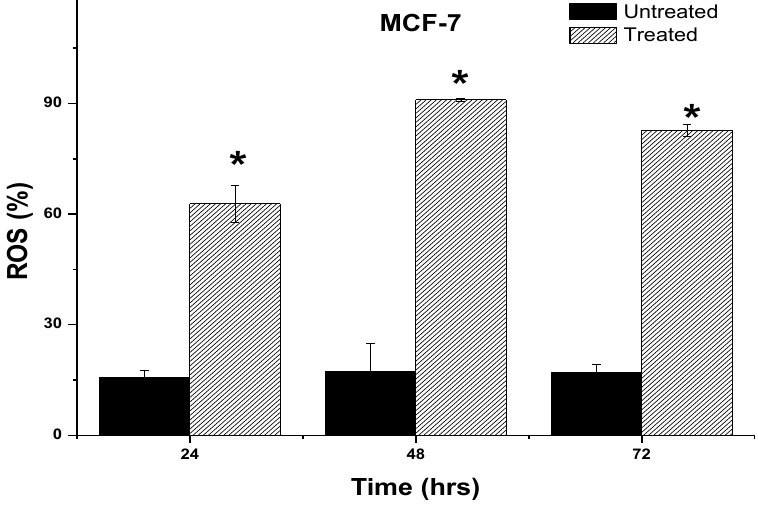
Figure 22. Percentage of reactive oxygen species in MCF-7 cells after treatment with 7-gerany loxycinnamic acid for 24, 48 and 72 h. Error bar represents mean ± standard deviation. * Significantly ( p < 0.05) different from